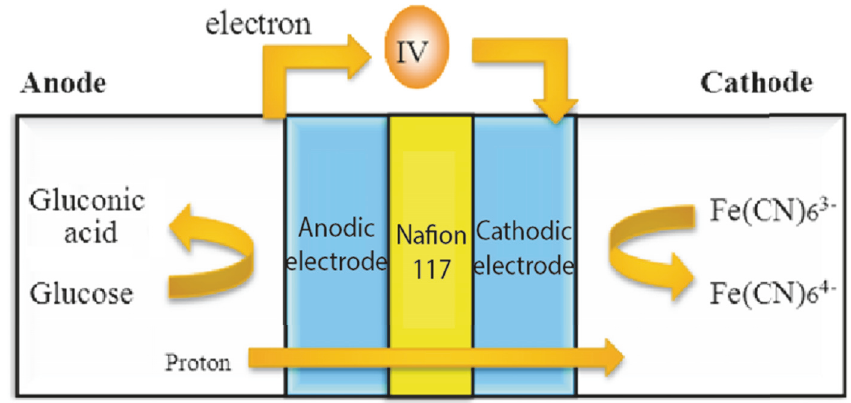
Figure 1: Enzymatic biofuel cell schematic showed the major components and its basic